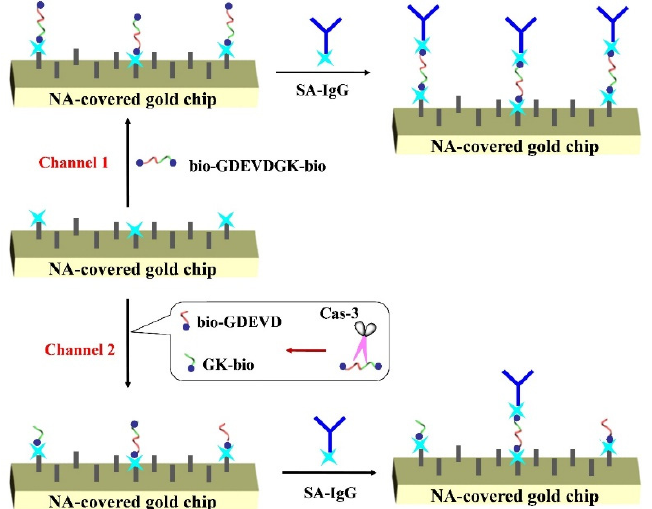
Scheme 1. Schematic representation of SPR method for the detection of Cas-3 using NA-covered gold chip. The signal was amplified by SA-IgG conjugates.